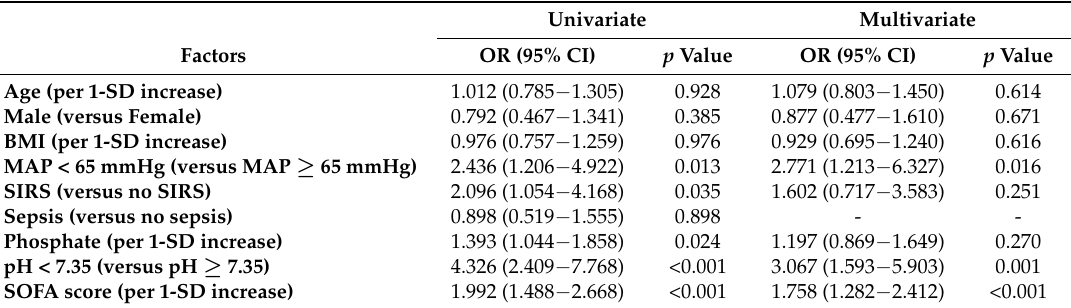
Table 3. Logistic regression analysis for early mortality *.